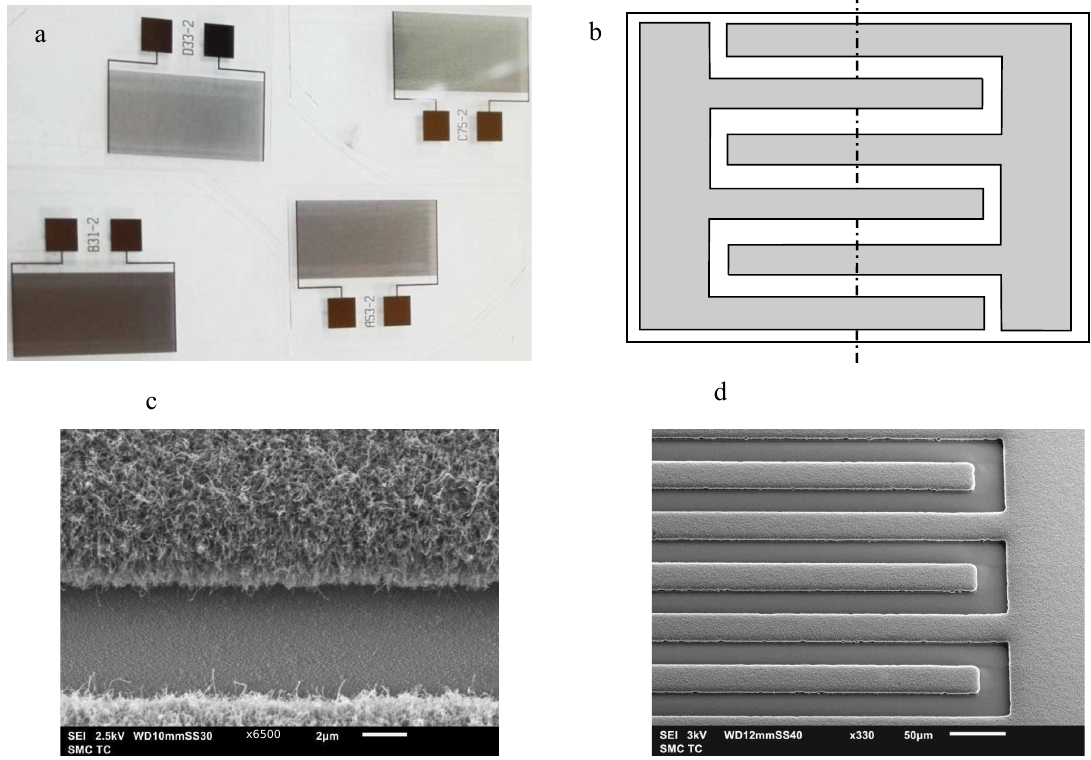
Figure 1. Planar supercapacitors studied in this work: photographs of several samples ( a ), planar geometry of PMSC ( b ), SEM images of multiwalled carbon nanotube (MWCNT) array in electrodes for different resolutions ( c , d ).